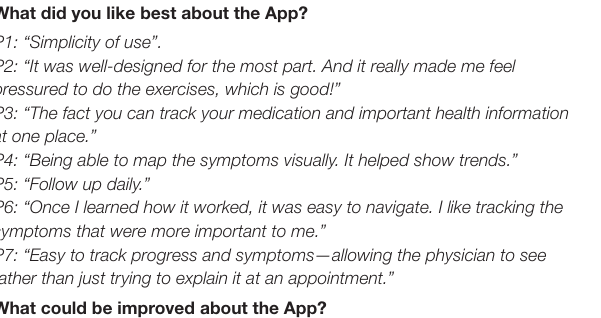
TABLE 4 | Qualitative findings (participant